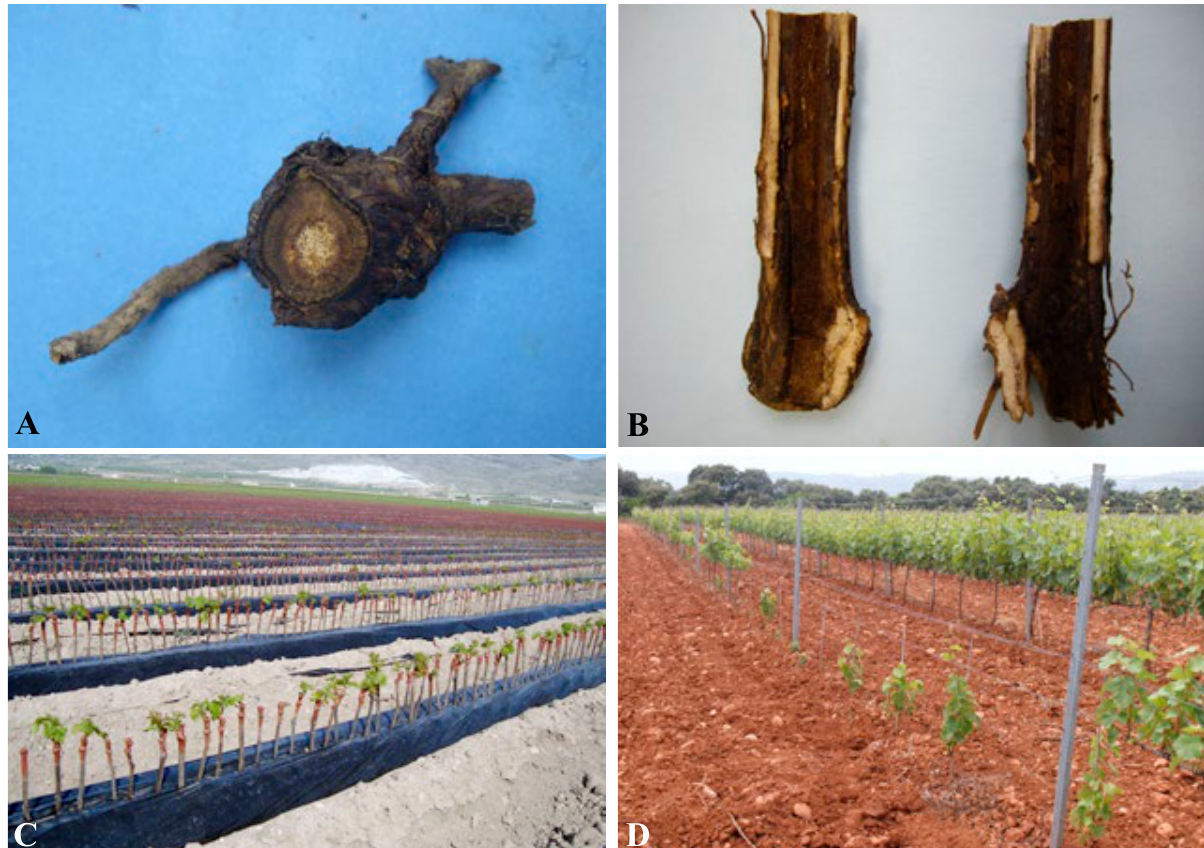
Figure 1. A, black discoloration and necrosis of wood tissue which develops from the base of the rootstock, characteristic of black-foot disease; B, longitudinal section of a rootstock showing dark-brown to black discoloration; C, Un-sprouted grapevine propagation material in a grapevine nursery; D, grapevine plants showing stunded growth, reduced vigour and retarded sprouting in a young